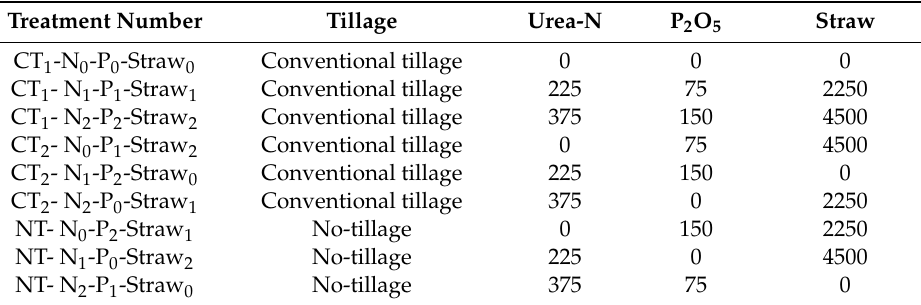
Table 2. Treatments in Quzhou of North China Plain experiment (kg ha − 1 yr − 1